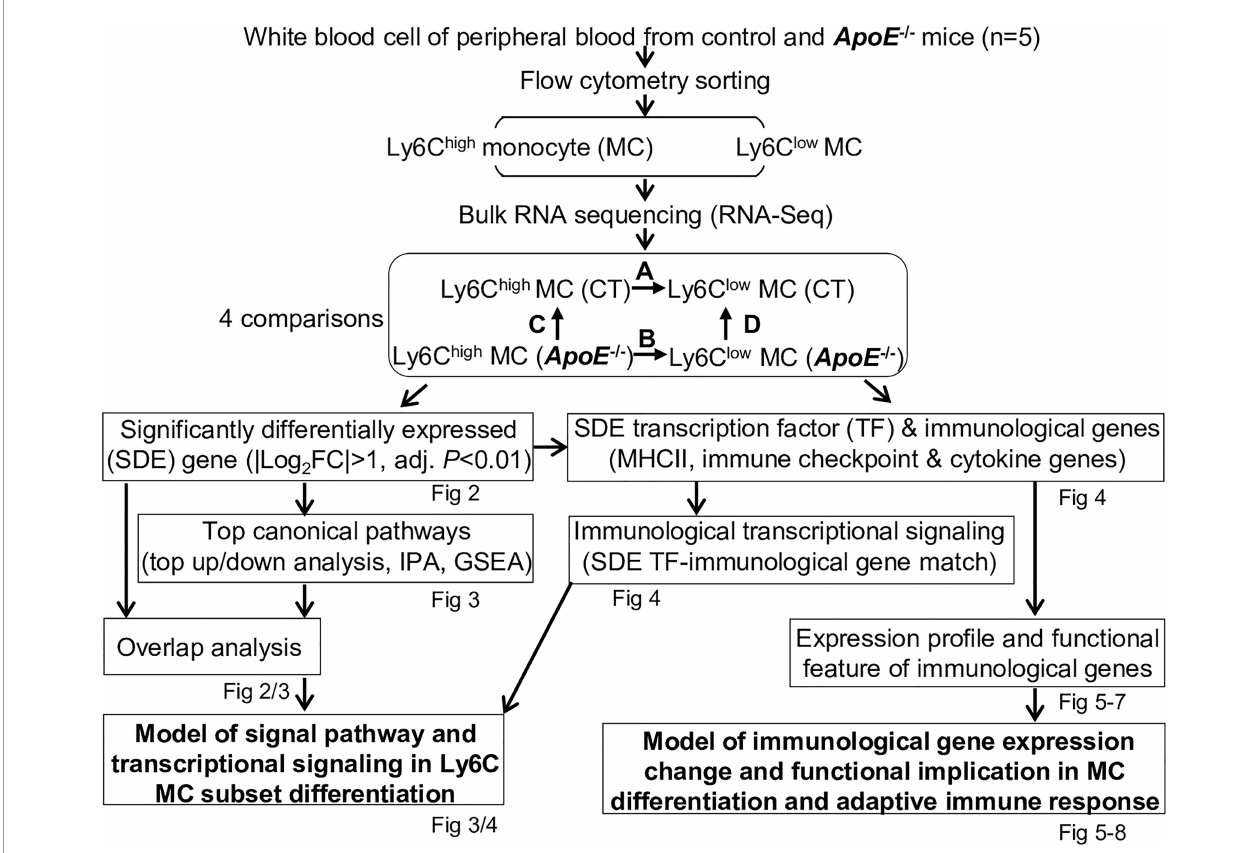
FIGURE 1 | Overall strategy of the identi fi cation of molecular signaling in Ly6C MC subset differentiation and adaptive immune response in control and ApoE -/- mice. RNA-Seq were performed in Ly6C high (CD11b + Ly6G − Ly6C high ) and Ly6C low (CD11b + Ly6G − Ly6C low ) MC isolated by fl ow cytometry sorting from peripheral blood of C57/BL6 control and ApoE -/- mice. Transcriptome data were analyzed by performing four pairs of comparisons: (A) Ly6C high vs Ly6C low (CT), (B) Ly6C high vs Ly6C low ( ApoE -/- ), (C) ApoE -/- vs CT (Ly6C high ), (D) ApoE -/- vs CT (Ly6C low ). SDE genes were identi fi ed by using the criteria of |Log 2 FC| more than 1 (2-FC) and adjusted P value less than 0.01. Top canonical pathways were recognized by top-down analysis using IPA with |Z-score|>2, P value<0.05. Overlapped analysis were performed for canonical pathways between groups. SDE TF and three sets of SDE immunological genes (MHCII, immune checkpoint and cytokine genes) were identi fi ed. Immunological SDE genes were matched with corresponding upstream SDE TF by IPA upstream analysis. Models of signal pathway and transcriptional signaling of Ly6C MC subset differentiation were developed. Expression pro fi le and functional feature of immunological SDE genes were characterized. Model of immunological gene expression change and functional implication in MC differentiation and adaptive immune response in MC subsets of both mice were developed. CT, control, ApoE, Apolipoprotein E; FC, fold change; RNA-seq, RNA-sequencing; MC, monocyte; SDE, signi fi cant differentially expressed; IPA, Ingenuity Pathway Analysis; GSEA, gene set enrichment analysis; TF, transcription